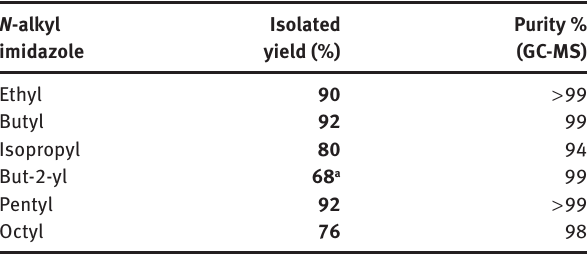
Table 5: Isolated yield and purity of N -alkyl